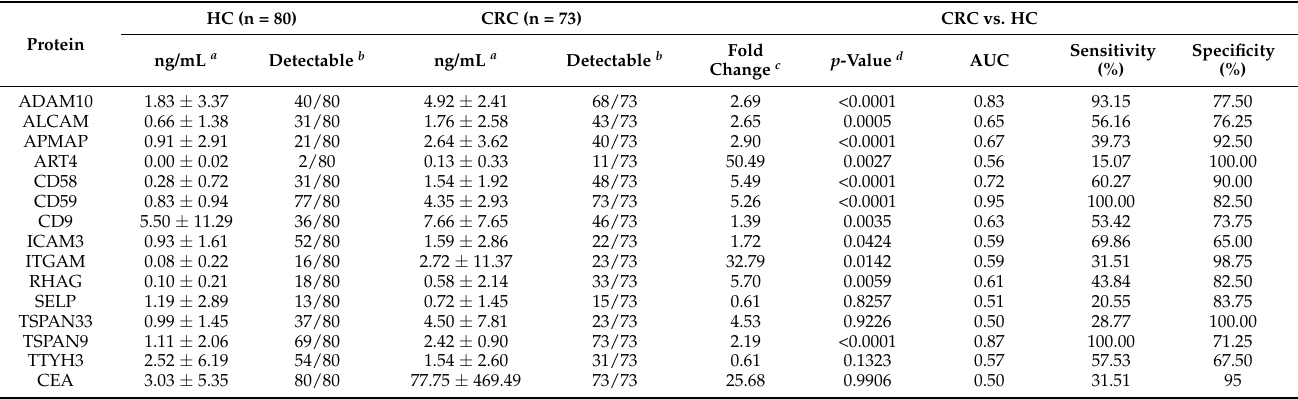
Table 2. Concentrations of 14 target proteins in plasma EV samples, as well as CEA in plasma samples, from HCs and CRC